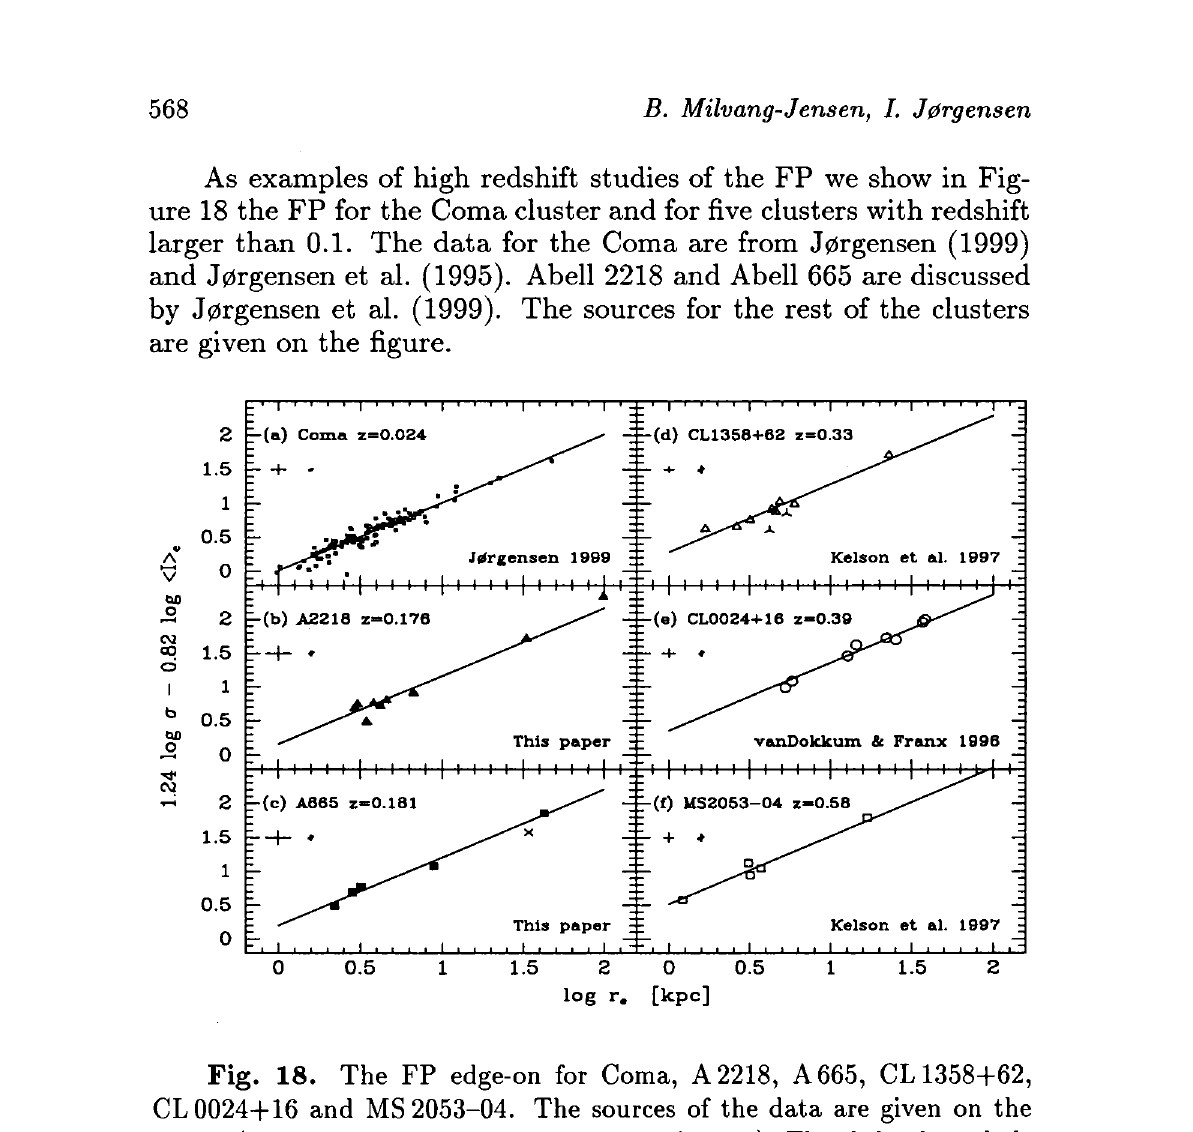
Fig. 18. The FP edge-on for Coma, A 2218, A 665, CL1358+62, CL 0024+16 and MS 2053-04. The sources of the data are given on the panels ('This paper' refers to J0rgensen et al. 1999). The skeletal symbols on panels (c) and (d) are the E+A galaxies. The photometry is calibrated to Gunn r in the rest frames of the clusters. The mean surface brightness log(7) = -0.4({/x) - 26.4) is in units of L©/pc 2 (cf. Section 2.4.1). e e The photometry is not corrected for the dimming due to the expansion of the Universe. The effective radii are in kpc (Ho =50 km/(s Mpc) and qo = 0.5). The solid lines are the FPs with coefficients adopted from J0rgensen et al. (1996) and with zero points derived from the data presented in the figure. Typical error bars are given on the panels; the thin and thick error bars show the random and systematic uncertainties, respectively. (From j0rgensen et al.